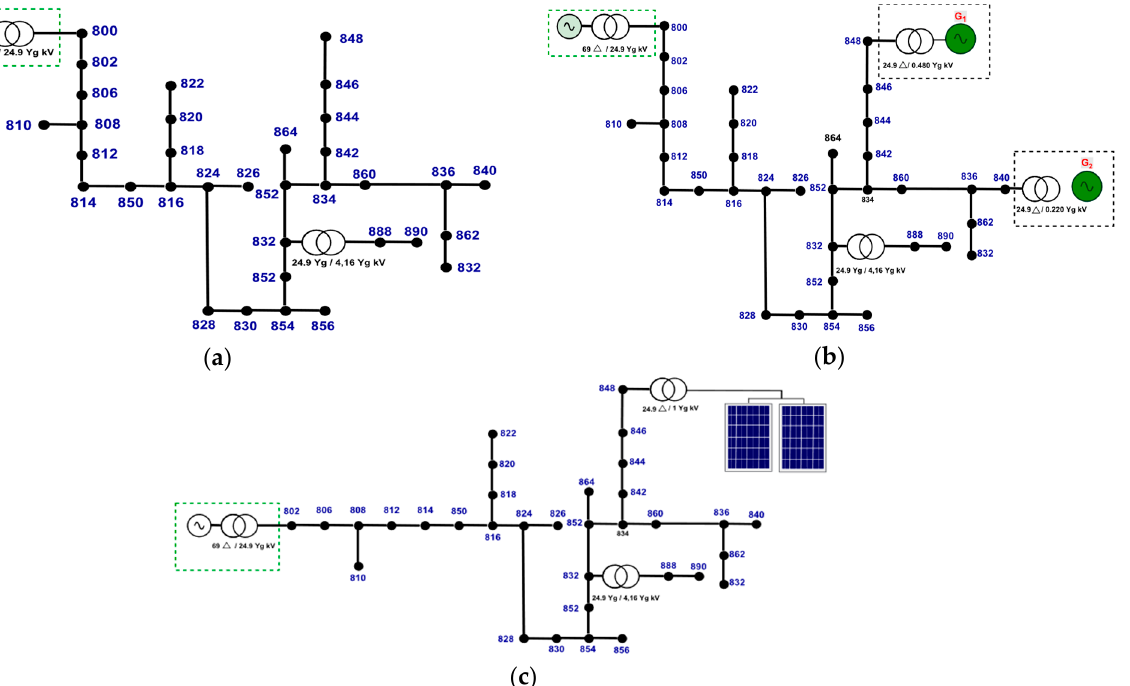
Figure 8. IEEE-34 bus test system. Fault Simulation: ( a ) Without DG unit (Scenario 1); ( b ) With two synchronous generators (Scenario 2); and ( c ) With PV panels (Scenario 3).